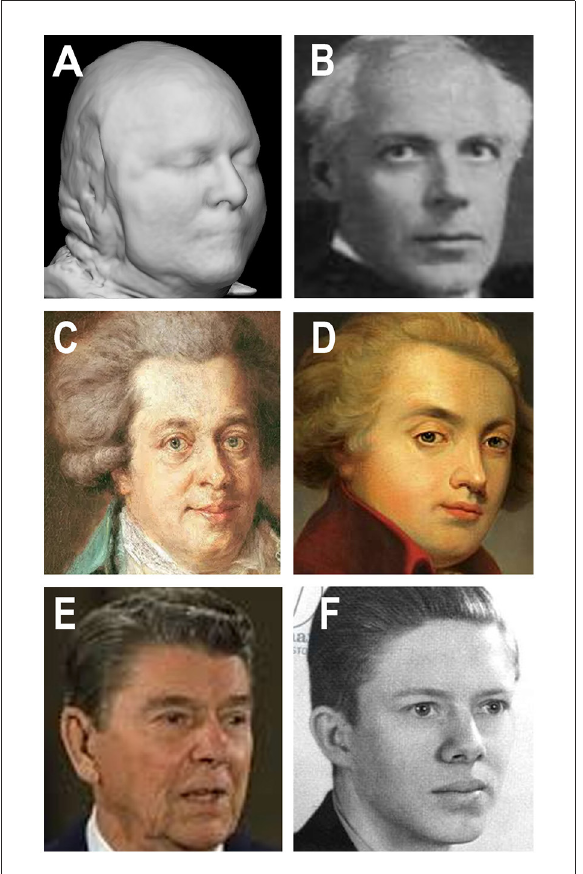
FIGURE1 Brain magnetic resonance imaging (MRI) imaging